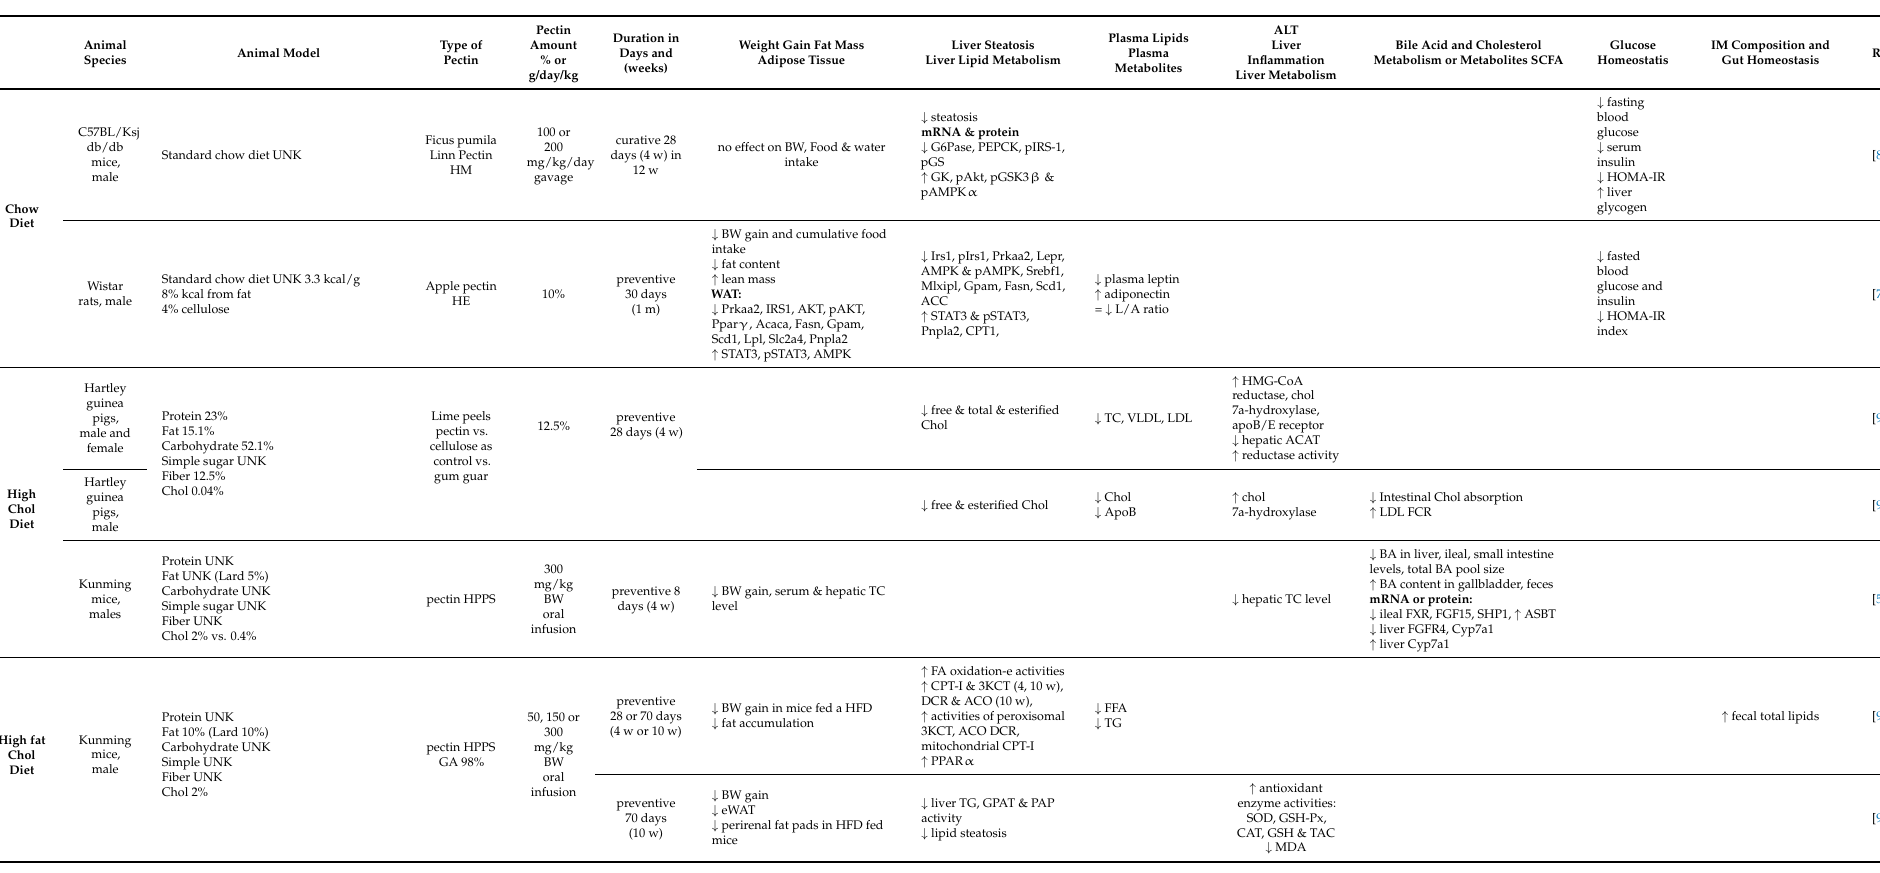
Table 2. Changes induced by a pectin-enriched diet to address liver injury in high-fat rodent models and non-alcoholic fatty liver disease. Summary of metabolic changes induced by pectin in studies addressing the improvement of liver injury in non-alcoholic liver